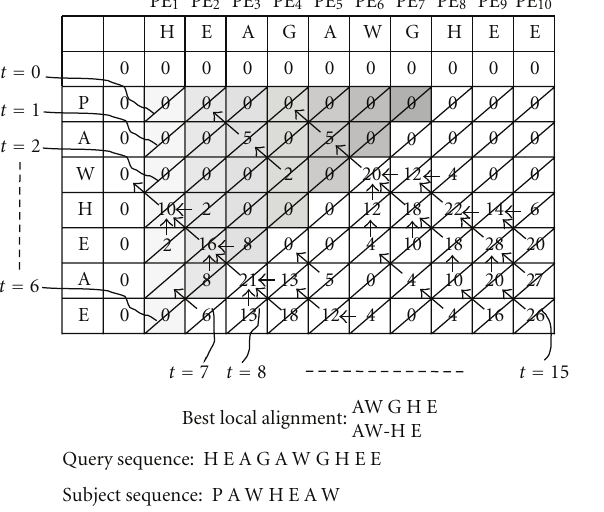
Figure 7: Illustration of the execution of the Smith-Waterman on the linear array